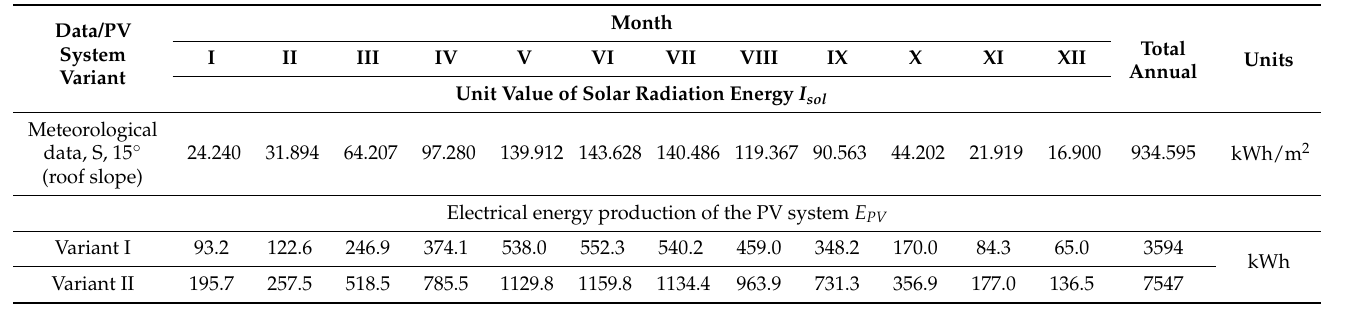
Table 7. Electrical energy production of the PV